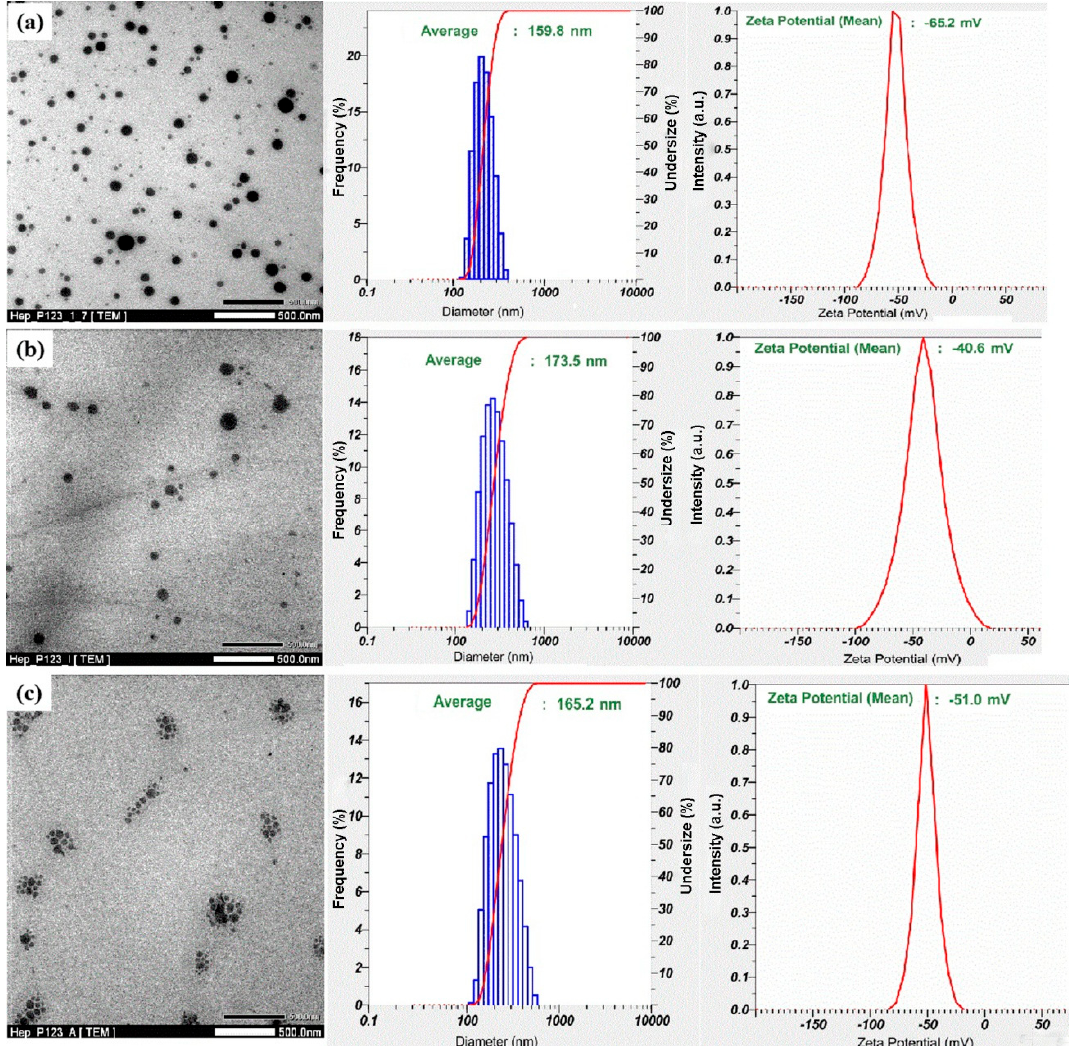
Figure 3. Transmission electron microscopy (TEM) images (left panels), dynamic light scattering (DLS) data (middle panels) and Zeta potential (right panel) of Hep-P123 ( a ) Hep-P123-IW ( b ) and Hep-P123-Ado ( c ).